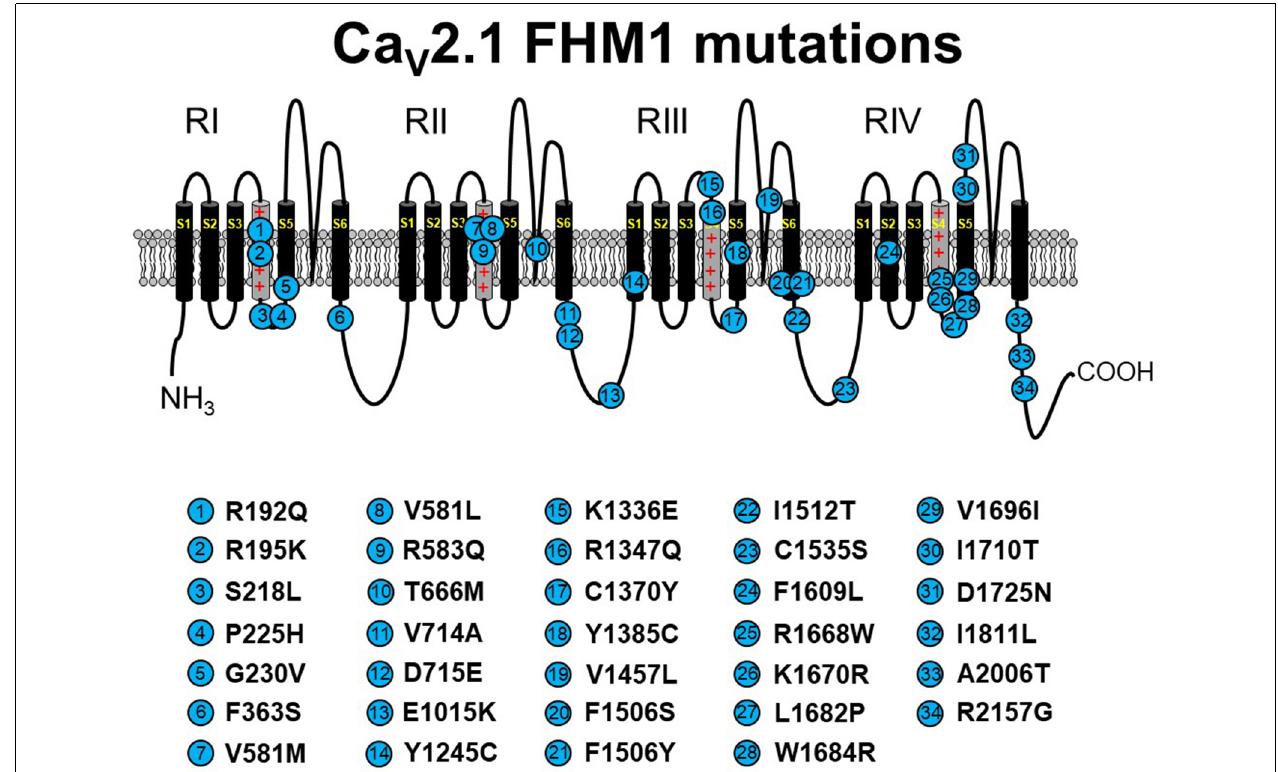
FIGURE 2 | Schematic representation of human Ca V 2.1 mutations causing familial hemiplegic migraine type 1 (FHM1). Please note that residue numbering varies between studies due to the existence of multiple CACNA1A splice variants; residue numbers indicated reflect those stated in the original report. Citations to the indicated mutations are listed as follows: R192Q—Ophoff et al. (1996); R195K—Ducros et al. (2001); S218L—Kors et al. (2001); P225H—Stuart et al. (2012); G230V—Yang et al. (2014); F363S—Riant et al. (2010); V581M—Cuenca-León et al. (2008); V581L—Freilinger et al. (2011); R583Q—Battistini et al.